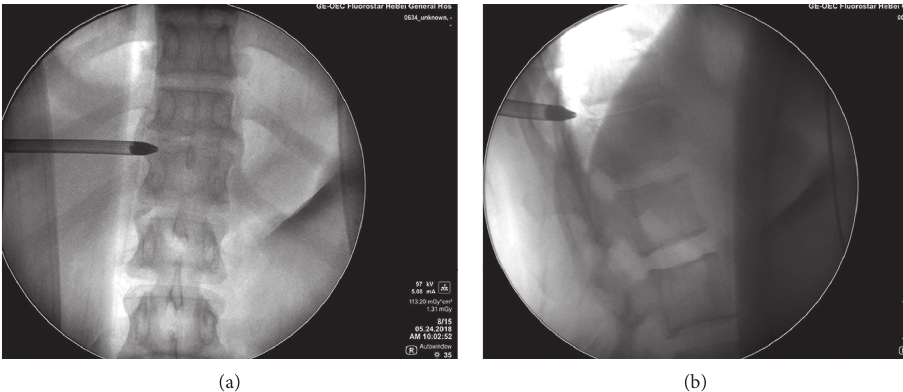
Figure 2: The dilator is located at the lower part of the intervertebral foramen, as can be checked on the lateral X-ray fluoroscopy (a) and anteroposterior X-ray fluoroscopy (b).